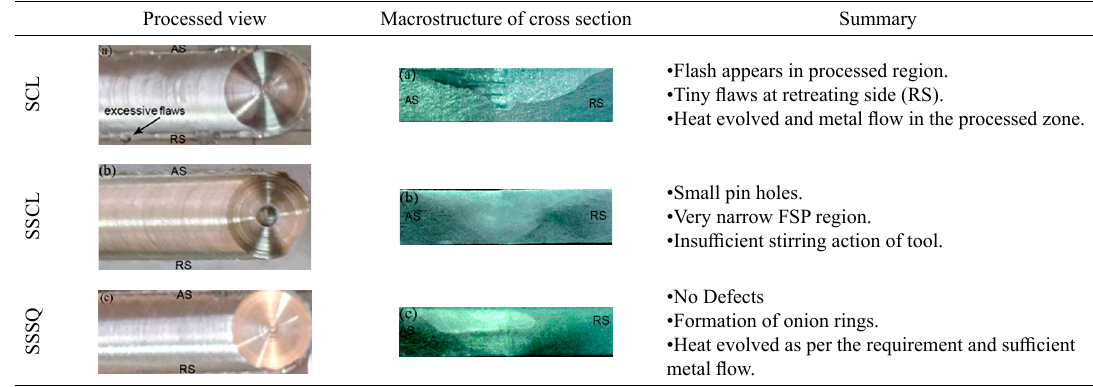
Table 3. Macrostructure and observations of processed region at 1000 rpm. Processed